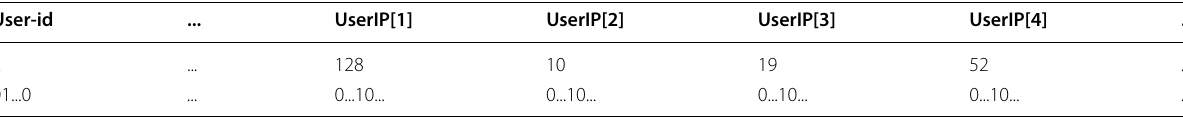
Table 3 One-hot Encoding for Fields